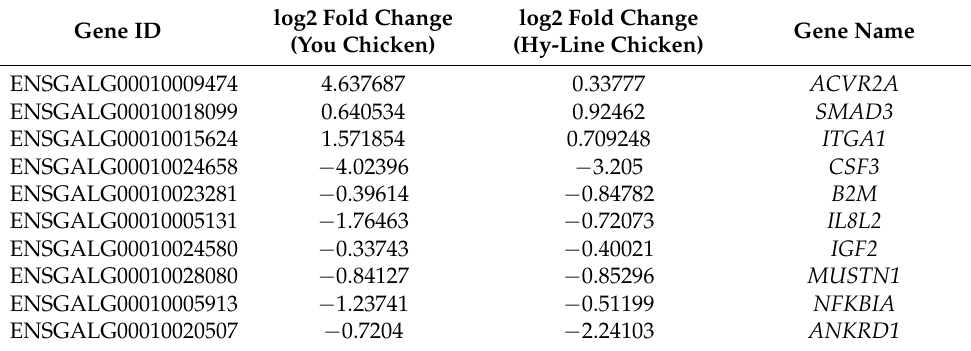
Table 1. Genes regulating the process of cell